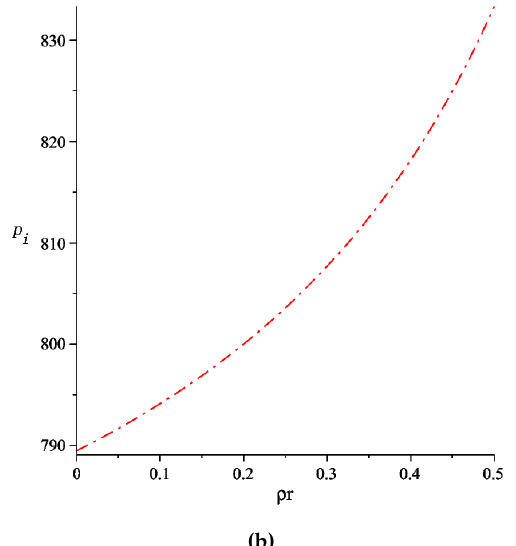
Figure 2. The effect of retailer’s altruistic preference coefficient on the decision of supply chain members. ( a ) The impact of retailer’s altruistic preference coefficient on greenness, wholesale prices and retail prices. ( b ) The impact of the retailer’s altruistic preference coefficient on retail prices.